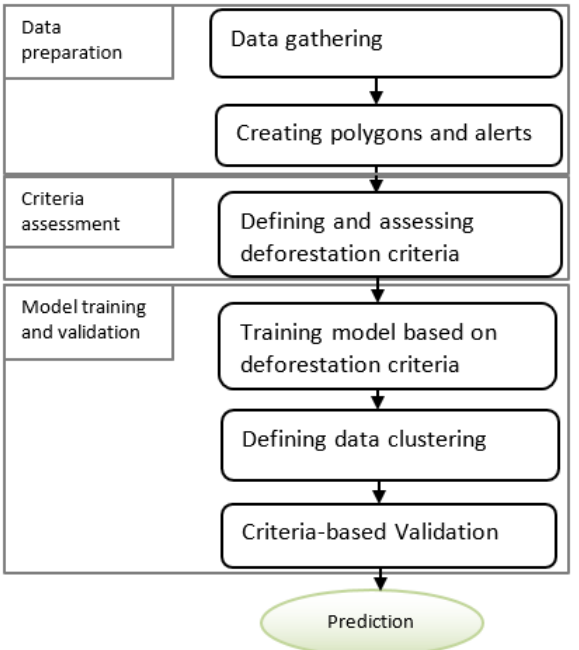
Figure 1. Proposed conceptual framework for deforestation prediction.